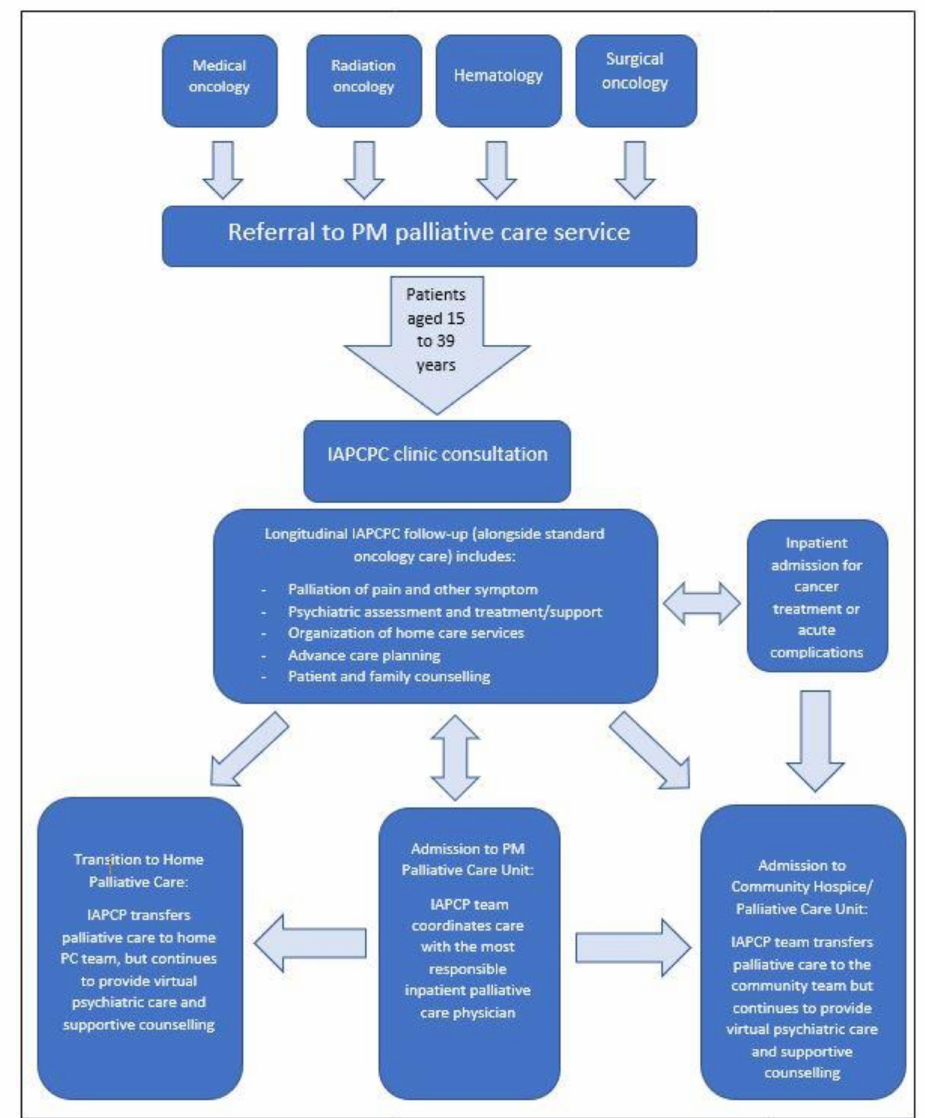
Figure 1. Integrated AYA Palliative Care and Psychiatry Clinic (IAPCPC) clinic model and steps of care for adolescent and young adult (AYA) cancer patients from time of